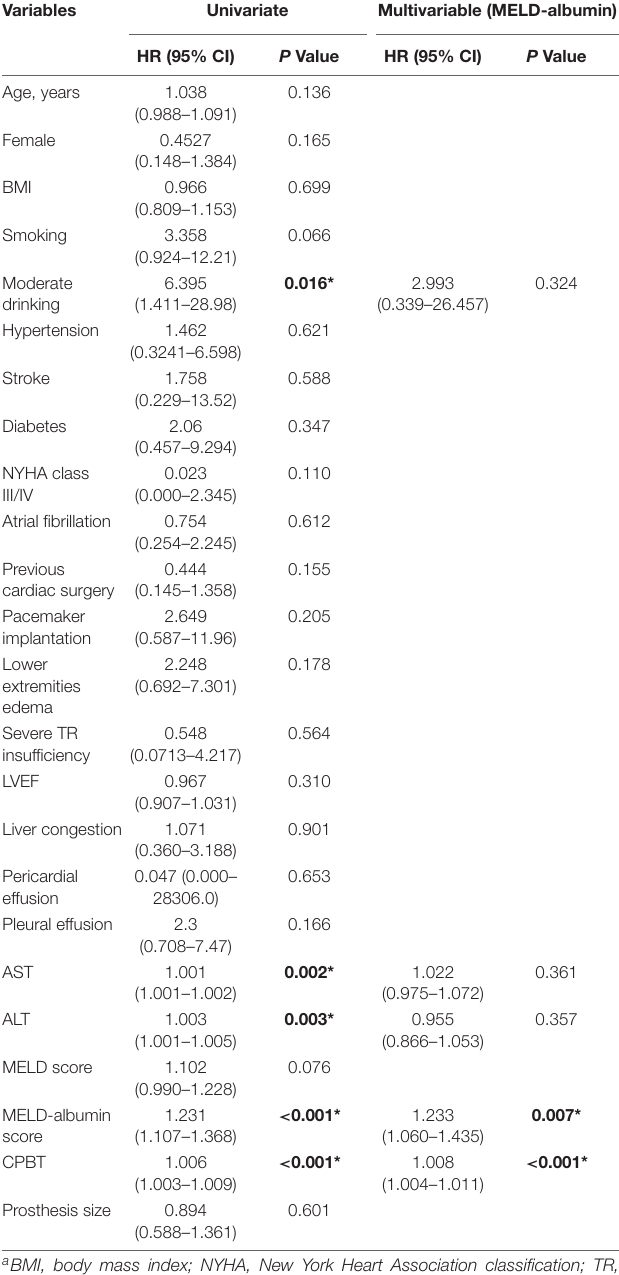
TABLE 2 | Cox regression analysis for perioperative characteristics predictive of in-hospital mortality. Variables